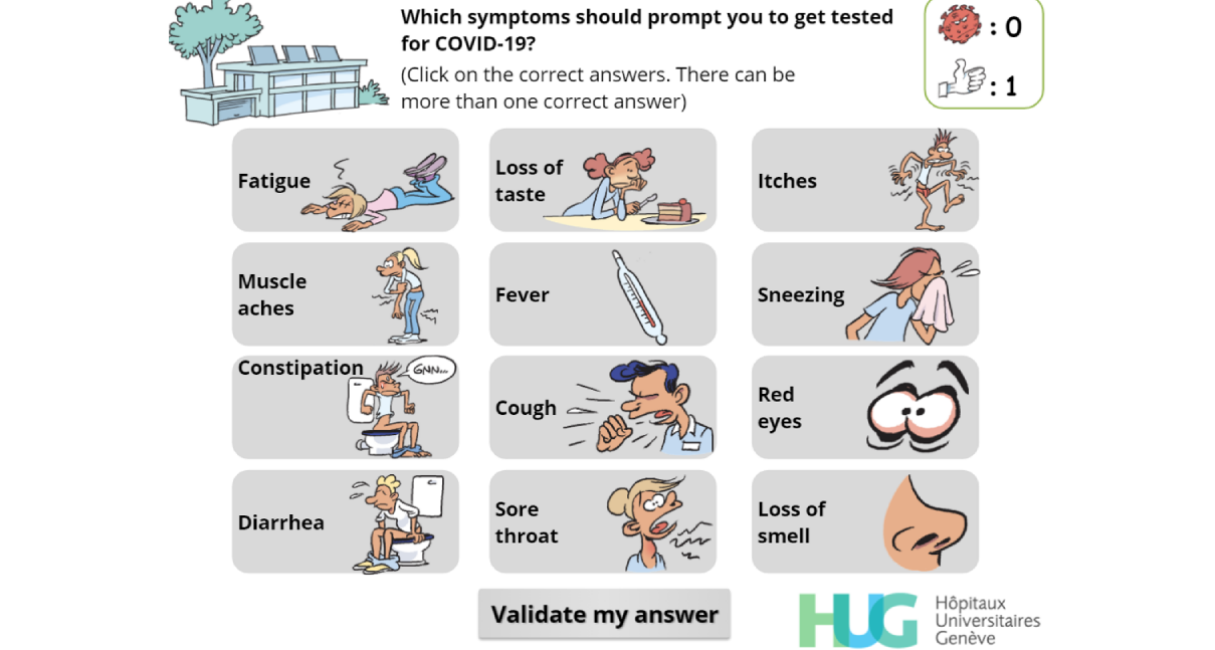
Figure 10. Multiple-choice interaction. The player has to identify the symptoms that should prompt a COVID-19 screening